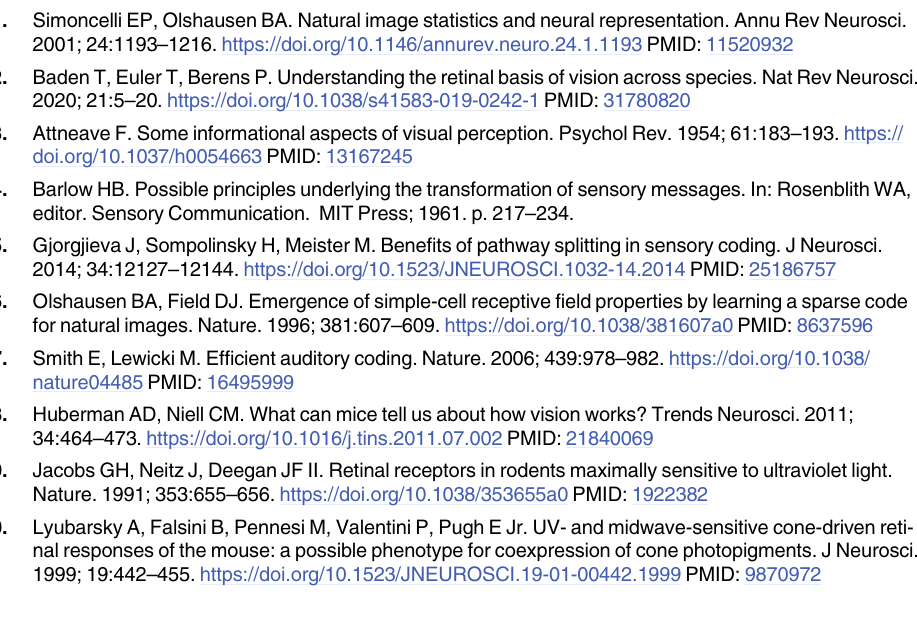
S4 Fig. Natural image statistics for “mouse-view” images have distinct spectral properties between upper and lower visual fields across different order statistics. The first- to the fourth-order image statistics (mean, A, B; standard deviation, C, D; skewness, E, F; kurtosis, G, H) as well as entropy (I, J) were computed for local images patches (0.36 degrees; UV, violet; Green, green). Joint (top) and marginal (bottom) probability distributions were then generated for the upper (A, C, E, G, I) and lower (B, D, F, H, J) visual field